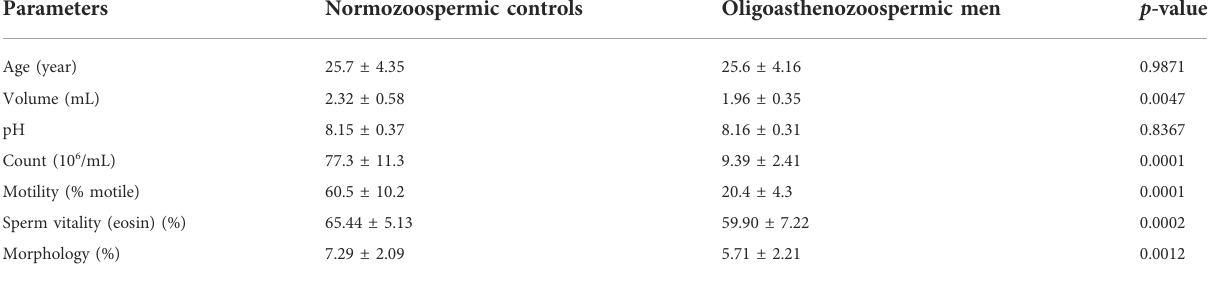
TABLE 1 Semen characteristics of the enrolled men. Parameters